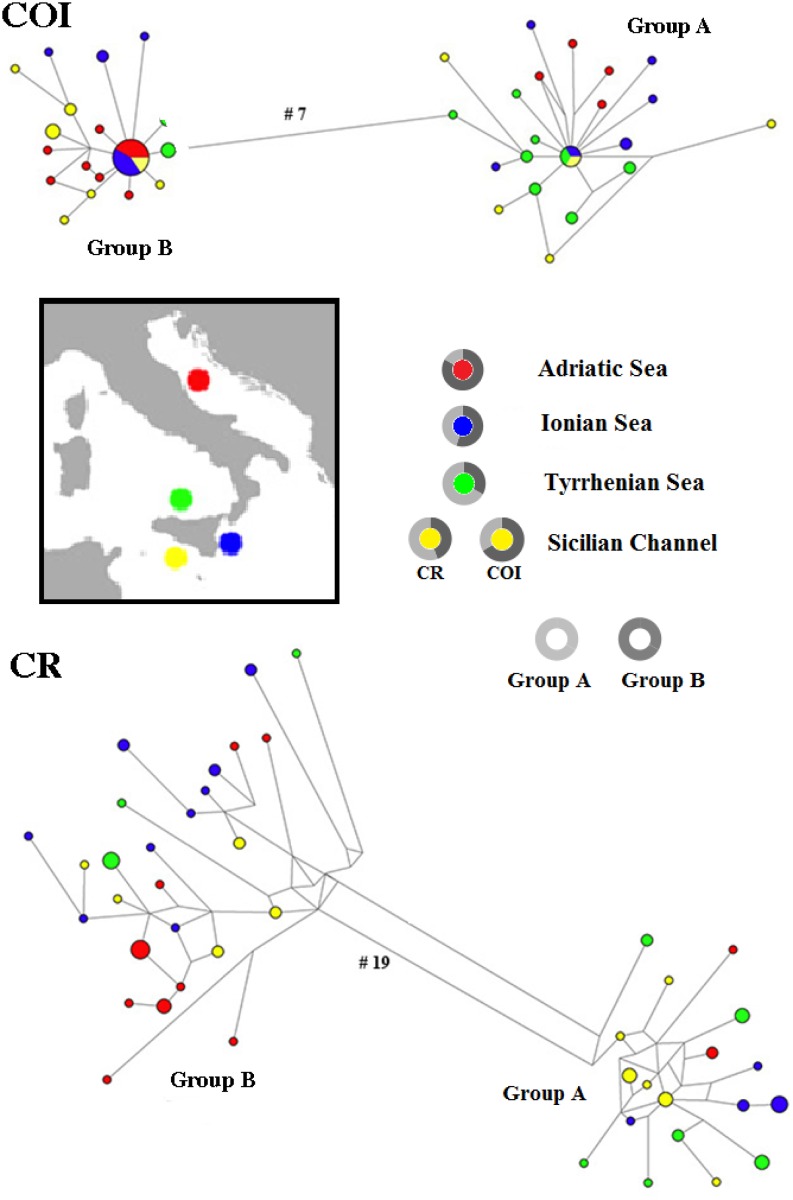
Median-joining network for the COI and CR of Engraulis encrasicolus.The area of the circles is proportional to each haplotype frequency. Colors refer to the region in which haplotypes were found. In the case where haplotypes are shared among regions, pie charts show the relative haplotype frequency in each region. Grey circles represent mtDNA CR and COI clades A (light grey) and B (dark grey) proportions. Only in the Sicilian Channel the relative proportion of the two clades is different for the two markers.